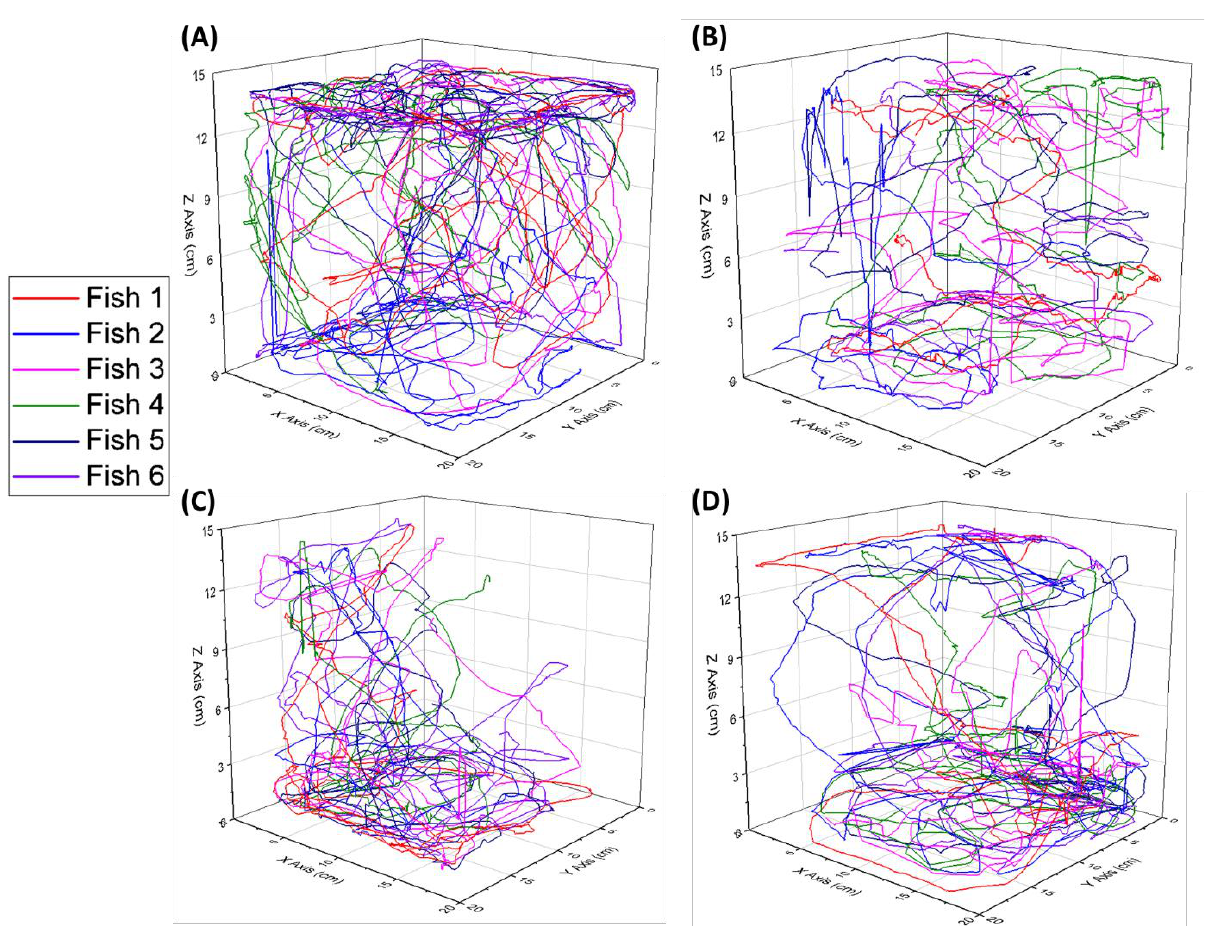
Figure A1. Swimming trajectories comparison of zebrafish exposed to antibiotics in 3D locomotion test. ( A ) Control; ( B ) Amoxicillin 100 ppb; ( C ) Trimethoprim 100 ppb; and ( D ) Tylosin 100 ppb. The trajectories were made from the 1st min. of recorded 5 min. video by inputting the X, Y, Z position during time interval into OriginPro ® software.